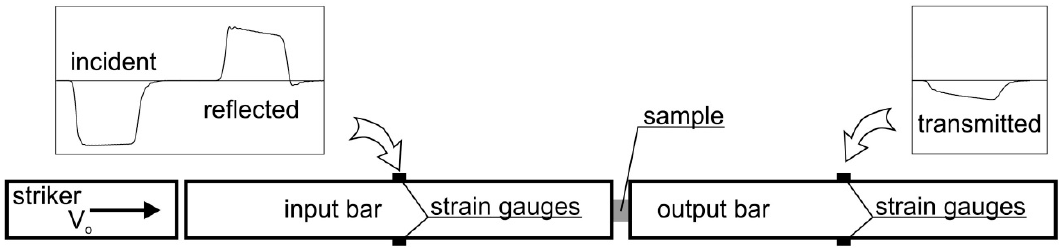
Figure 3. Split Hopkinson pressure bar (SHPB) set-up with strain gauges position and recorded signals.